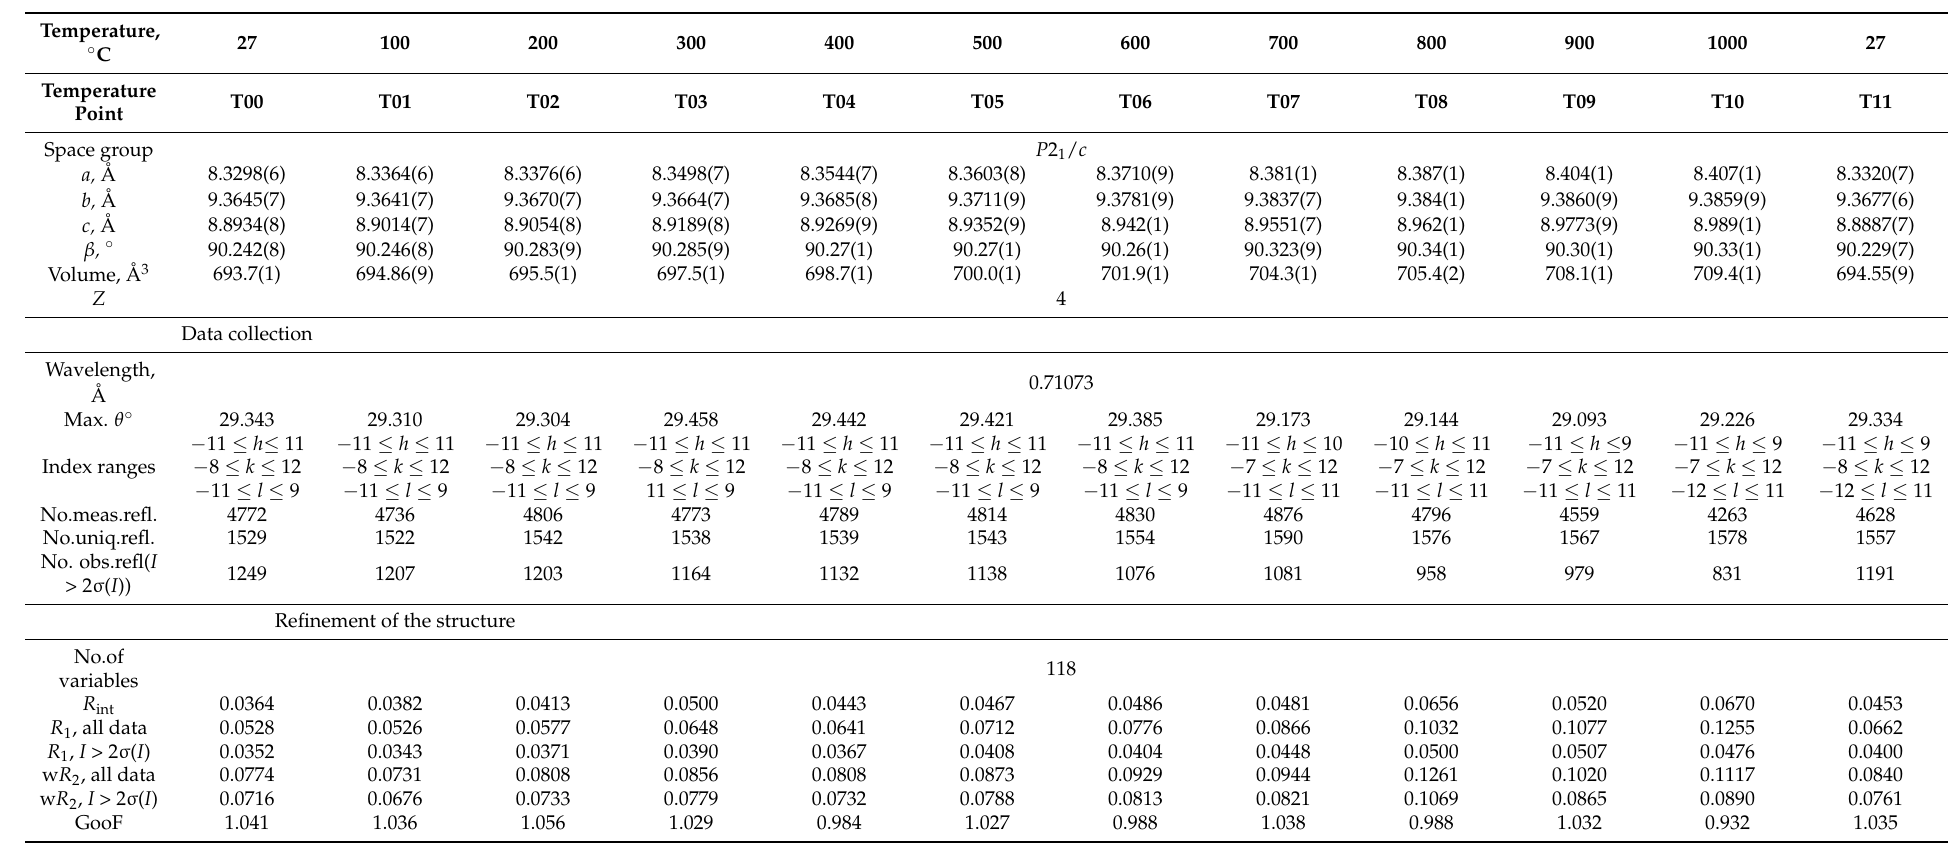
Table 1. Crystallographic data and refinement parameters for slawsonite SrAl 2 Si 2 O 8 at different temperatures in the P 2 1 / c space